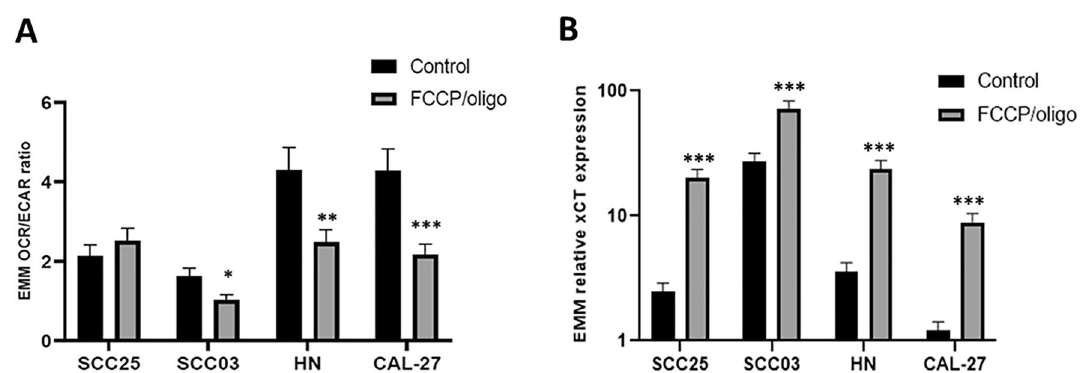
Figure 4. OCR/ECAR ratio ( A ) and xCT expression ( B ) of 4 HNSCC cell lines in response to FCCP/ oligomycin (EMM: Estimated marginal mean; bars: SEM; *p < 0.05, **p < 0.01, ***p <